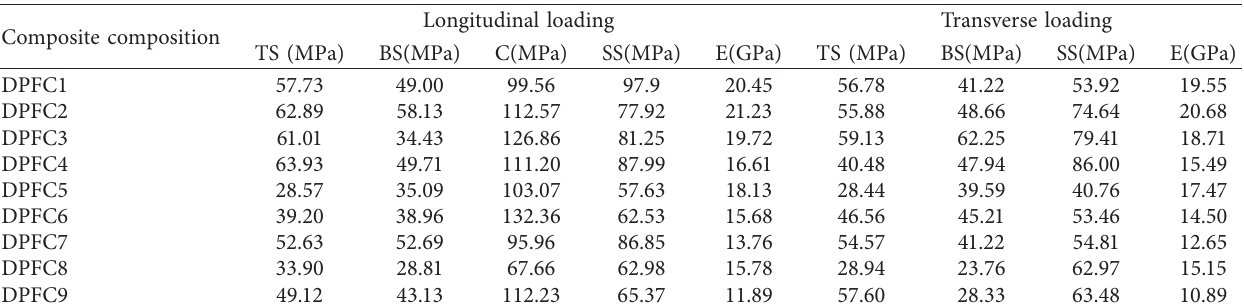
Table 7: Overall mechanical DPF composite property